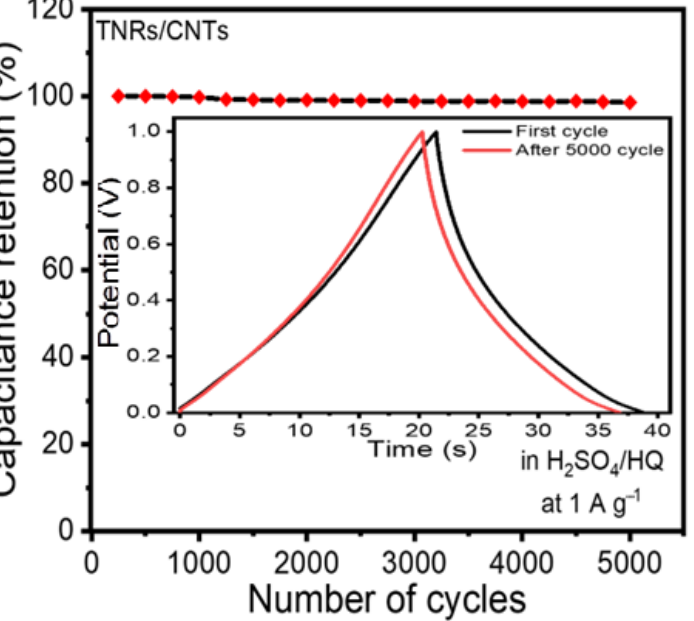
Figure 6. Stability of the electrode’s performance. The electrode retained 95.5 percent of its initial capacitance after 5000 cycles. The inset shows the first and last cycle for the charge/discharge curves.